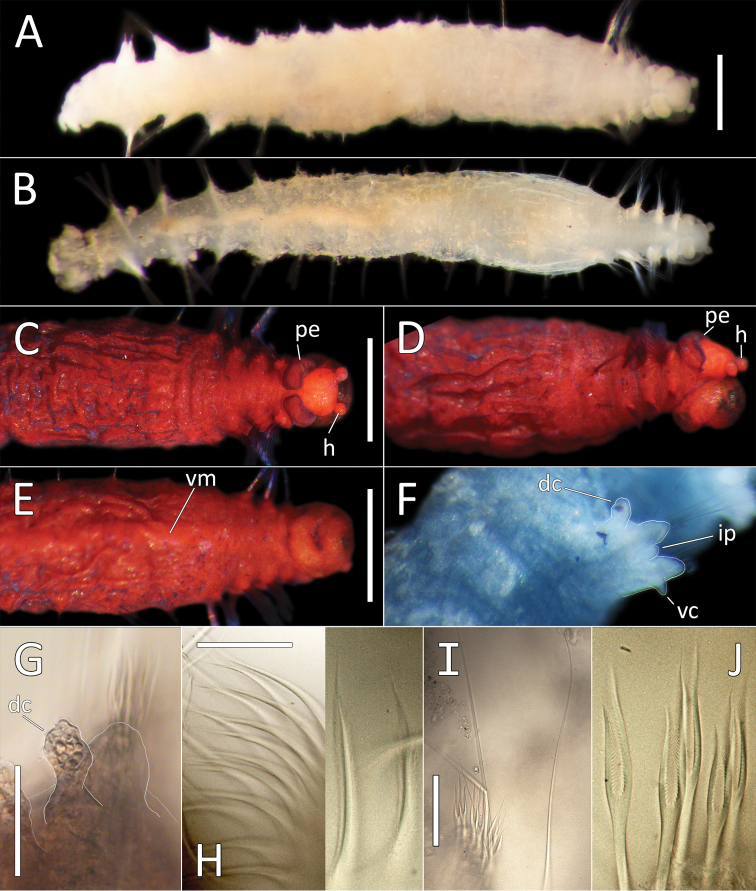
Oligobregma
tani sp. nov. holotype (specimen NHM_1454). A Lab image, whole specimen (pre-stain,) B Live image, whole specimen C Lab image, dorsal anterior, (stained, h = prostomial horns, pe = peristomial ring) D Lab image, lateral anterior, (stained, h = prostomial horns, pe = peristomial ring) E Lab image, ventral anterior, (stained, vm = ventral midline) F Lab image, mid-body parapodia (faded stain, dc = dorsal cirrus, vc = ventral cirrus, ip = interramal papilla) G Lab image, detail of dorsal cirrus, with no internal gland visible (dc = dorsal cirrus) H Lab image, detail of hirsute spines on notopodia on chaetiger 1 ([left panel]) I Lab image, detail of capillary and lyrate chaetae on chaetiger 12 J Lab image, detail lyrate chaetae. Morphological features in plates F, G have been outlined with a fine white line to improve clarity of those features. Scale bars: 0.5 mm (A, C, E); 50 μm (G–I).